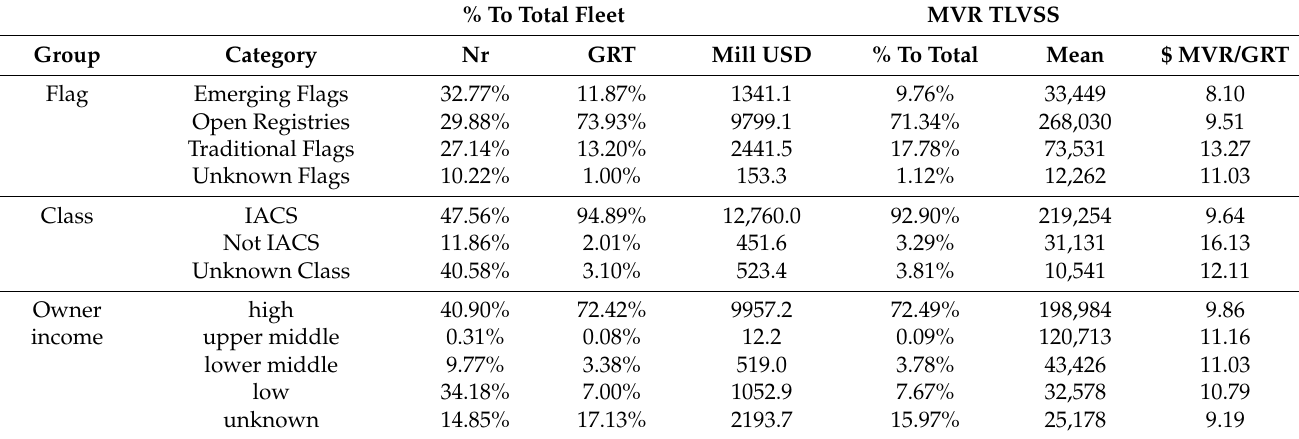
Table 4. MVR (TLVSS) by flag, classification society, and owner group (2017–2020 yearly mean). % To Total Fleet MVR